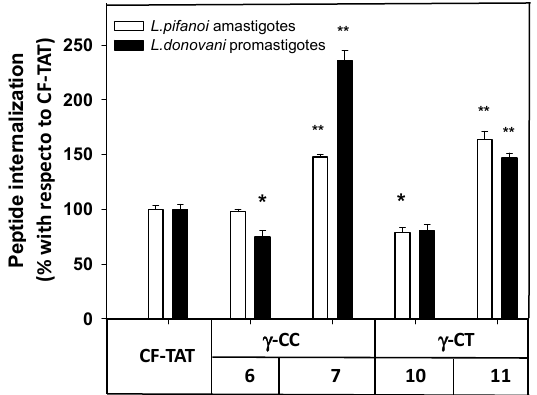
Figure 6. Flow cytometry of carboxyfluoresceinated 6 , 7 , 10 and 11 and TAT 48–57 peptides associated with Leishmania pifanoi amastigotes and Leishmania donovani promastigotes. Parasites (20 × 10 6 cells/mL) were incubated for 4 h with the respective CF-peptides at 10 μ M. Afterwards, peptide association to parasites was assessed by flow cytometry ( λ EXC = 488 nm, λ EM = 519 nm) and represented as the percentage with respect to TAT-CF ± SD. White bars: Leishmania pifanoi axenic amastigotes; black bar: Leishmania donovani promastigotes. Statistical significance was referred with respect to the uptake of carboxyfluoresceinated TAT: p ≤ 0.05, (*); p ≤ 0.01, (**). Results are representative of one out of three independent experiments. Samples were made in triplicate.